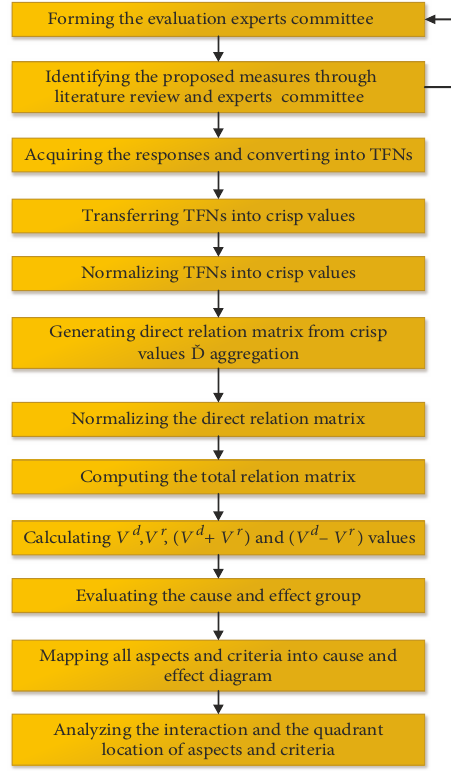
Figure 1. Flowchart of fuzzy DEMATEL